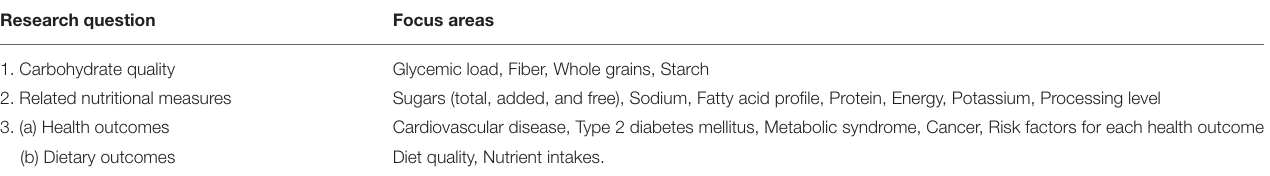
TABLE 1 | Summary of focus areas identified by the